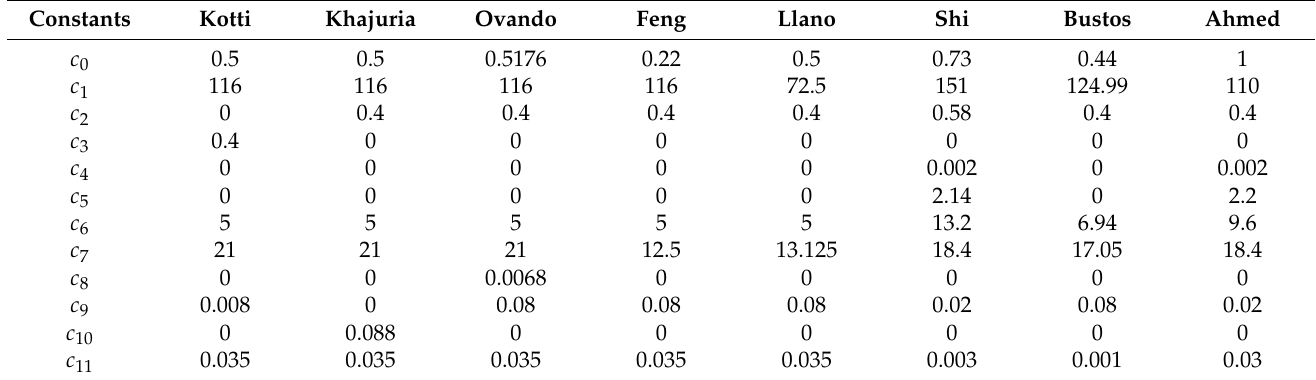
Table 3. Constants of the power coefficients found in relation to the general exponential